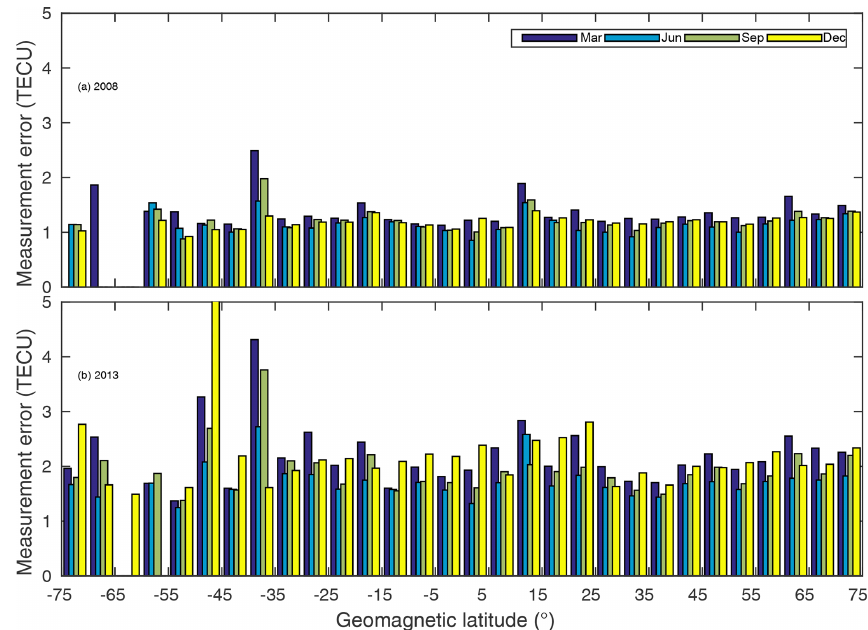
Figure 4. Latitudinally averaged measurement errors during the calendar months shown in the legend for the two solar activity periods.